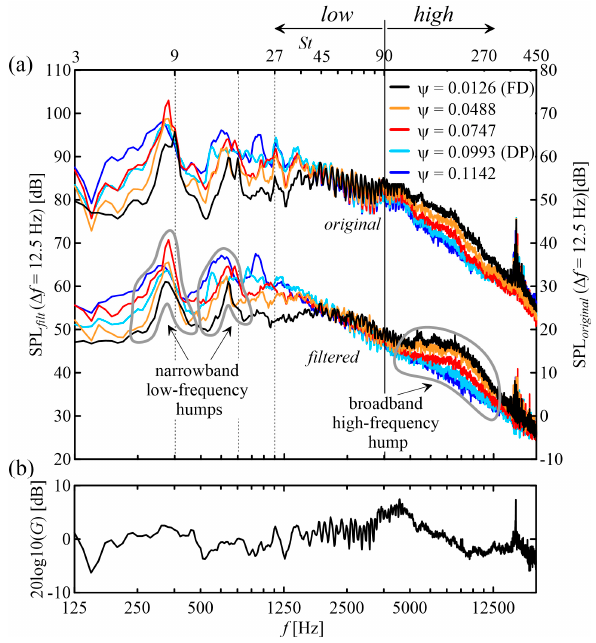
Figure 5. Acoustic measurements at fixed BS width. ( a ) Original and filtered SPL spectra at Ω = 2500 rev/min; ( b ) propagation function.